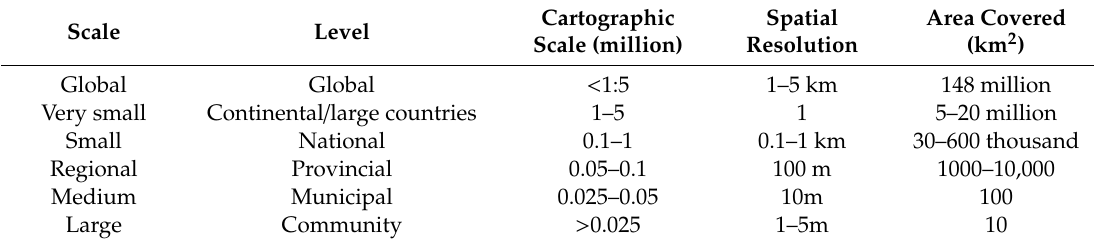
Table 9. Scales for hazard